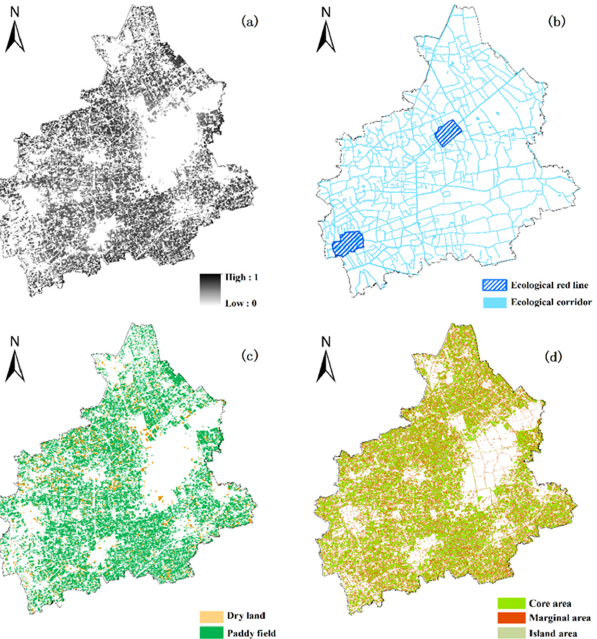
Figure 4. Ecological function evaluation factors of cultivated land in Tongxiang City: ( a ) habitat quality; ( b ) ecological importance; ( c ) cultivated land subcategory; ( d ) spatial pattern of cultivated land.